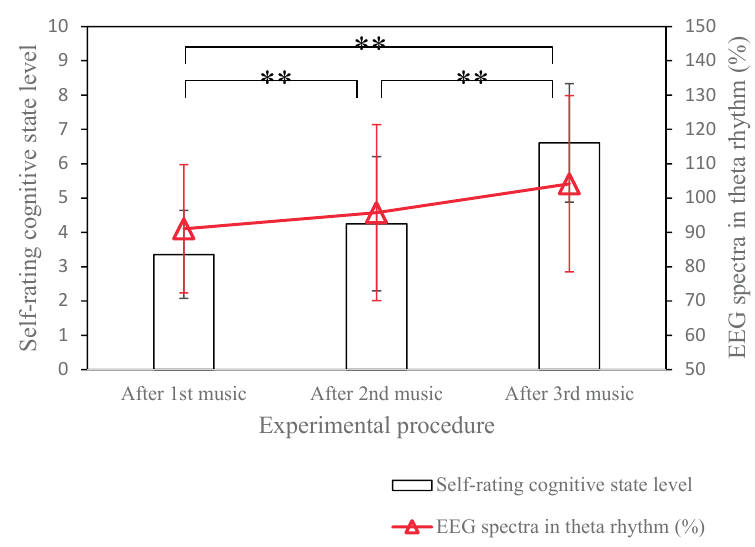
Figure 9. Self-rating cognitive state level and EEG spectra in theta rhythm under music biofeedback. Here, ** denotes